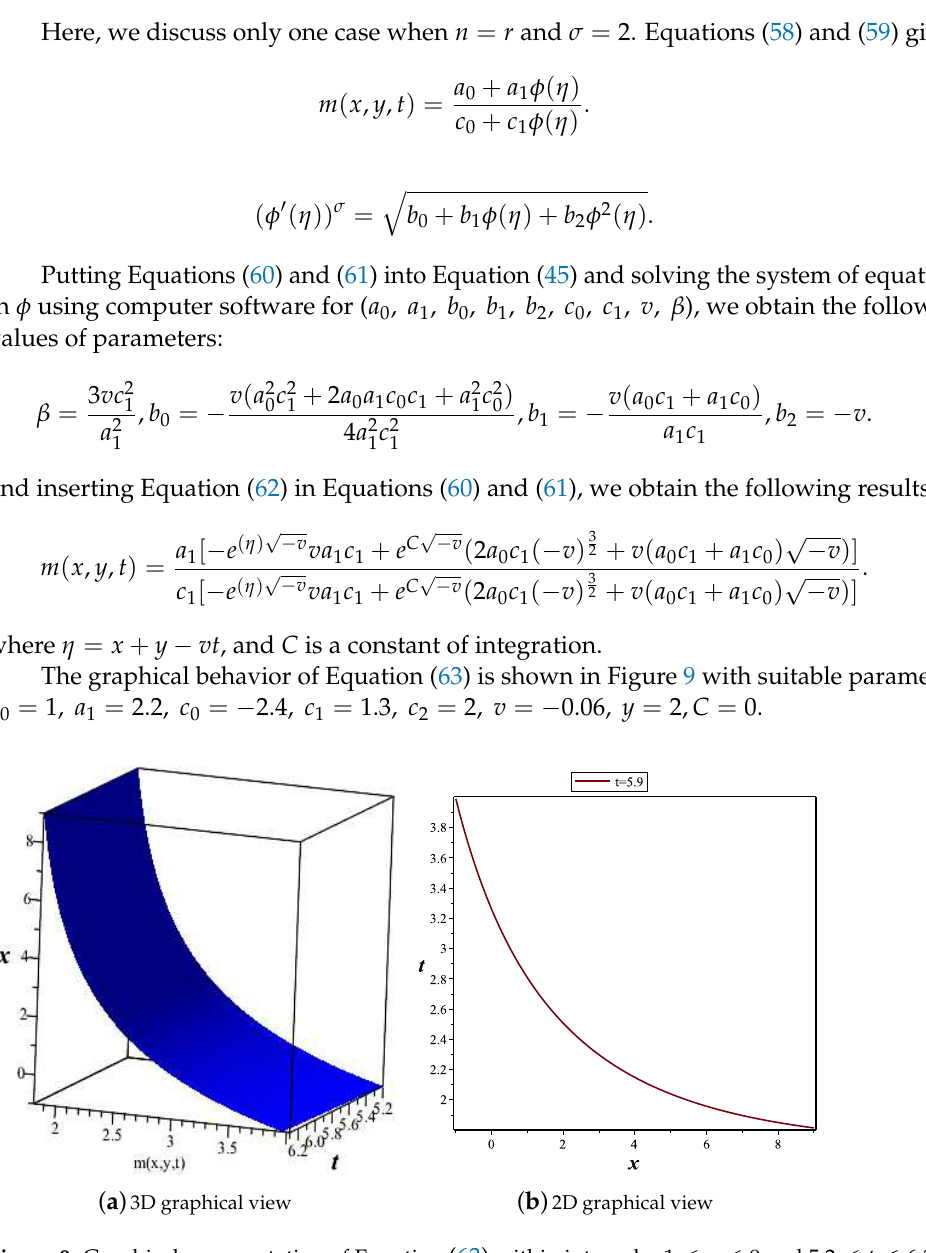
Figure 9. Graphical representation of Equation (63) within interval − 1 ≤ x ≤ 9 and 5.2 ≤ t ≤ 6.3 (( a ) 3D plot, ( b ) 2D plot for t =